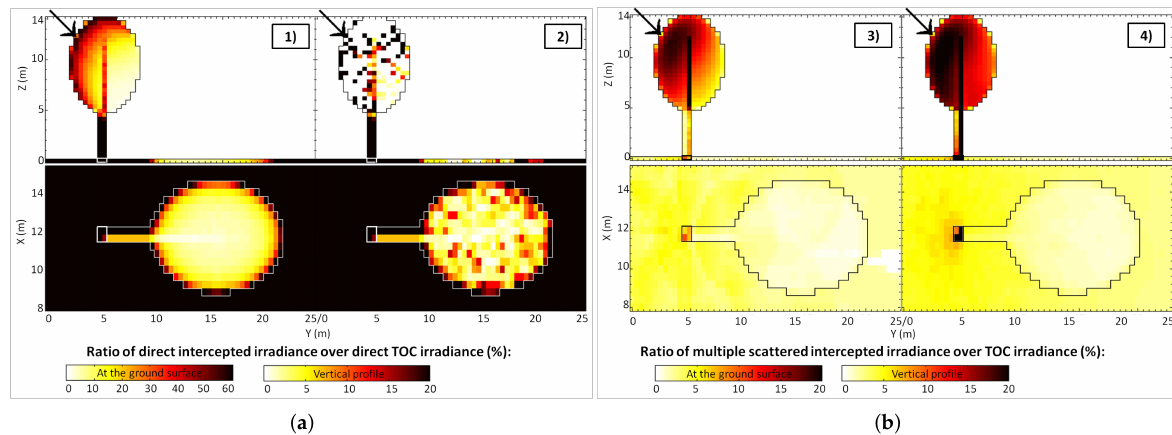
Figure 2. This is a wide figure. Figure 12. Ratio of the direct and multiple scattered intercepted irradiance over I TOC through a vertical profile at X = 11.2 m (first row) and ( a ) T dir or ( b ) T scat computed at the ground surface Z = 0 m (second row) for the empirical tree model at 0.8 µ m with (1) and (3) the base simulation scenario, (2) POROSITY = 70% and (4) BACKGROUND = grass (solar direction indicated by the black arrow, crown spatial extents delineated in black, shadow and trunk location in black or white).